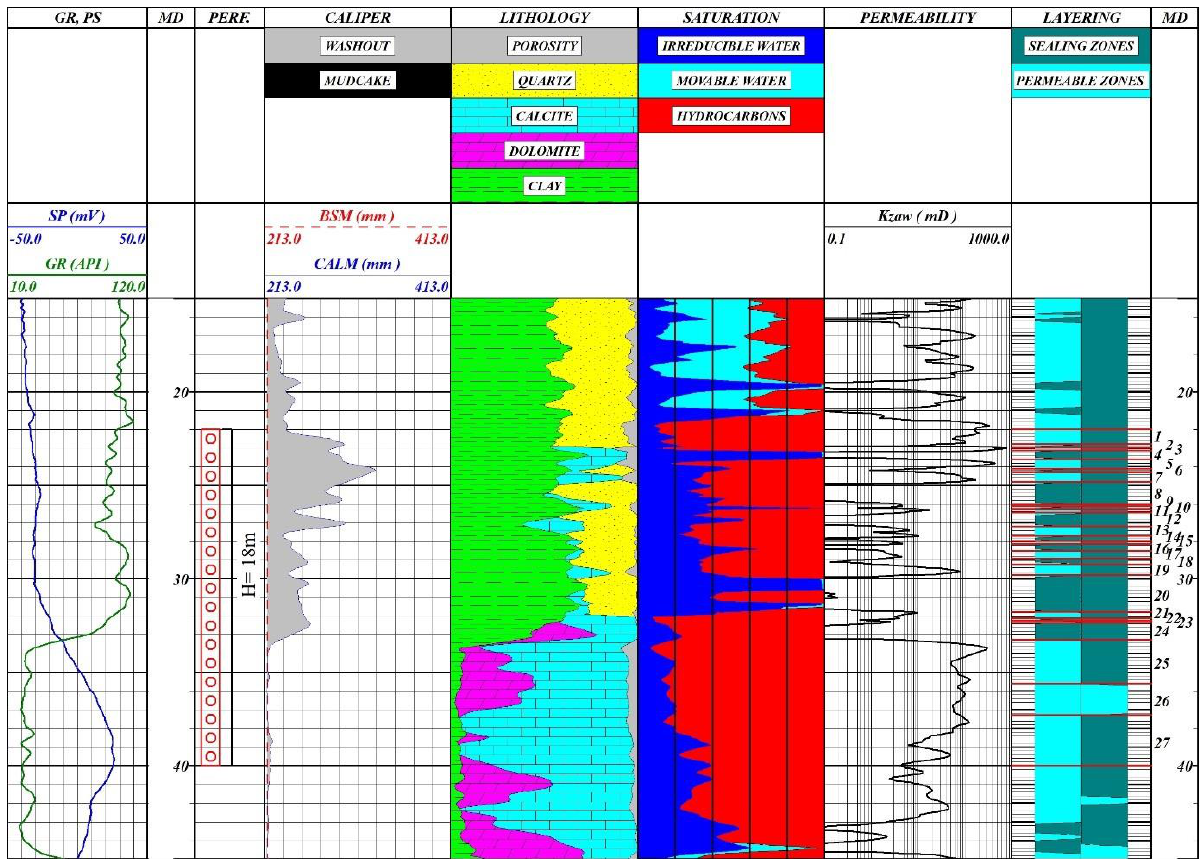
Figure 10. Results of the interpretation of the permeability changes profile within the analysed perforation interval in the Z-1K well.